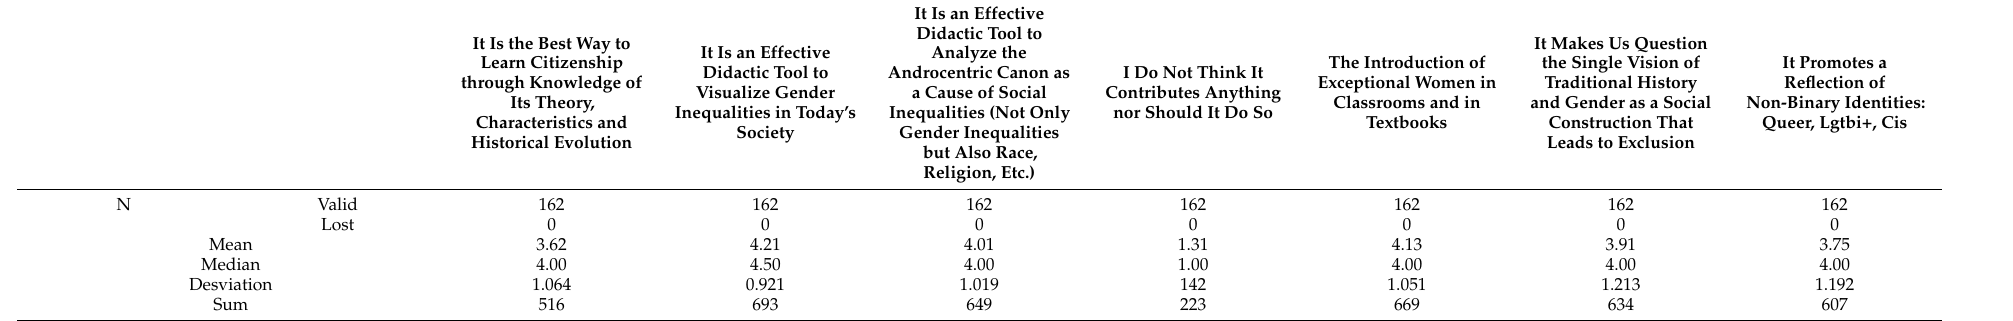
Table 7. Measures of key trends (mode, median and arithmetical average) for question